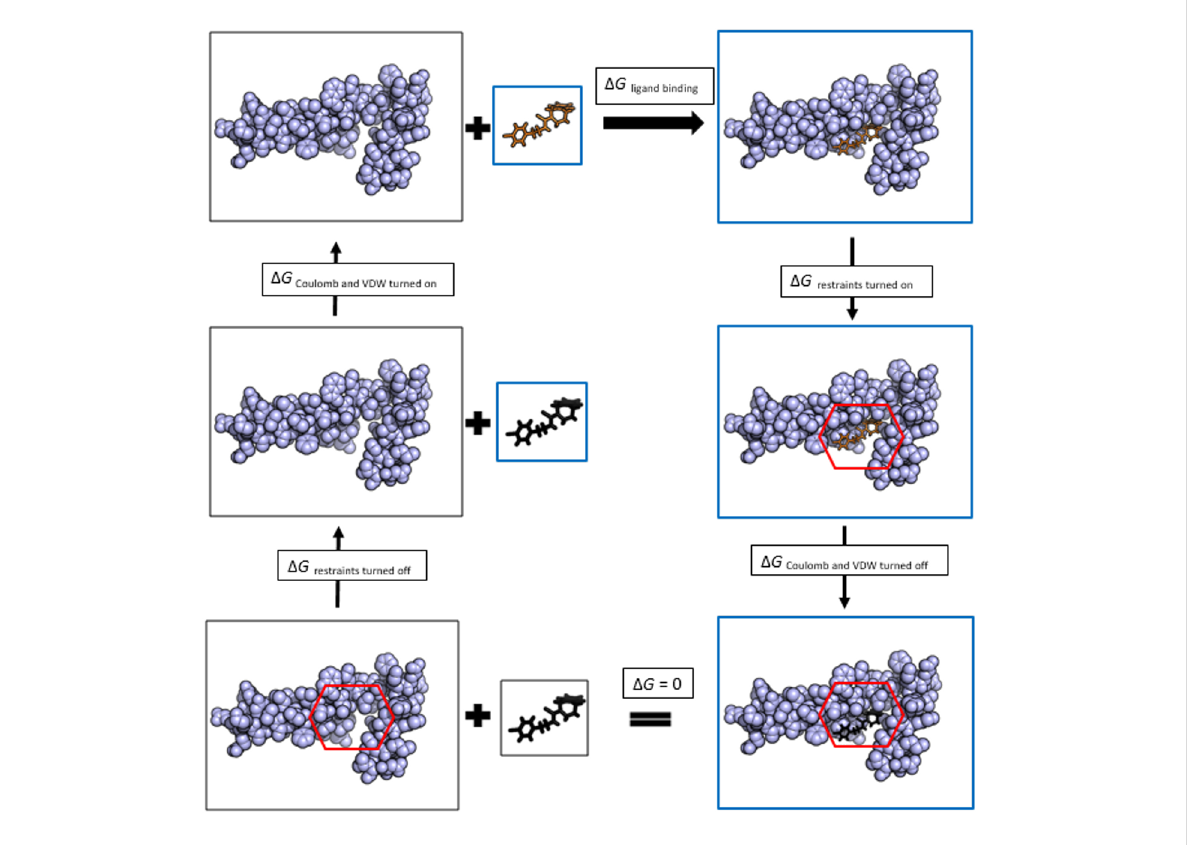
Figure 7: An example alchemical thermodynamic cycle for a protein–ligand binding free energy calculation. The protein is shown in blue spheres. The ligand, depicted in solid black, indicates there are no coulombic or van der Waals (VDW) interactions with the environment. The ligand, depicted in solid orange, indicates there are coulombic and VDW interactions with its environment. The systems that are subjected to simulations in each cycle are highlighted in blue boxes. All simulations are run in a water environment. The first step is to add restraints between ligand and the protein in order to keep the ligand confined to the binding pocket and to avoid the ligand leaving the pocket when its interactions are removed. The systems with restraints turned on are indicated by red hexagons. In the next step the coulombic and VDW interactions of the ligand are removed. This step is fol- lowed by the removal of the restraints applied to the ligand. Next the coulombic and VDW interactions of the ligand are turned on such that the ligand is in contact with solvent. Summing up the free energy changes along the thermodynamic cycle would give the protein–ligand binding free